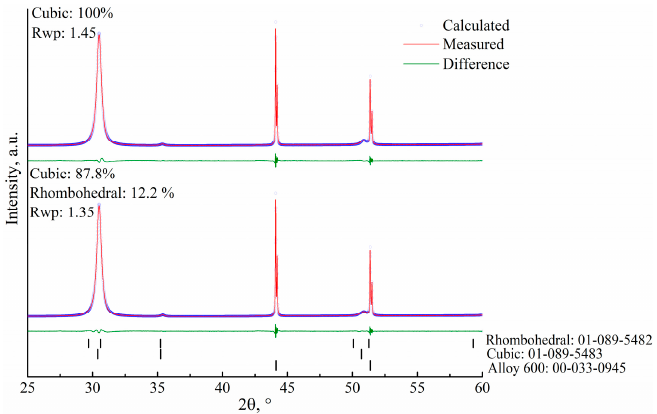
Figure 3. Rietveld analysis of XRD patterns of ScSZAl thin films deposited on Alloy 600 substrates using a 0.4 nm/s deposition rate.